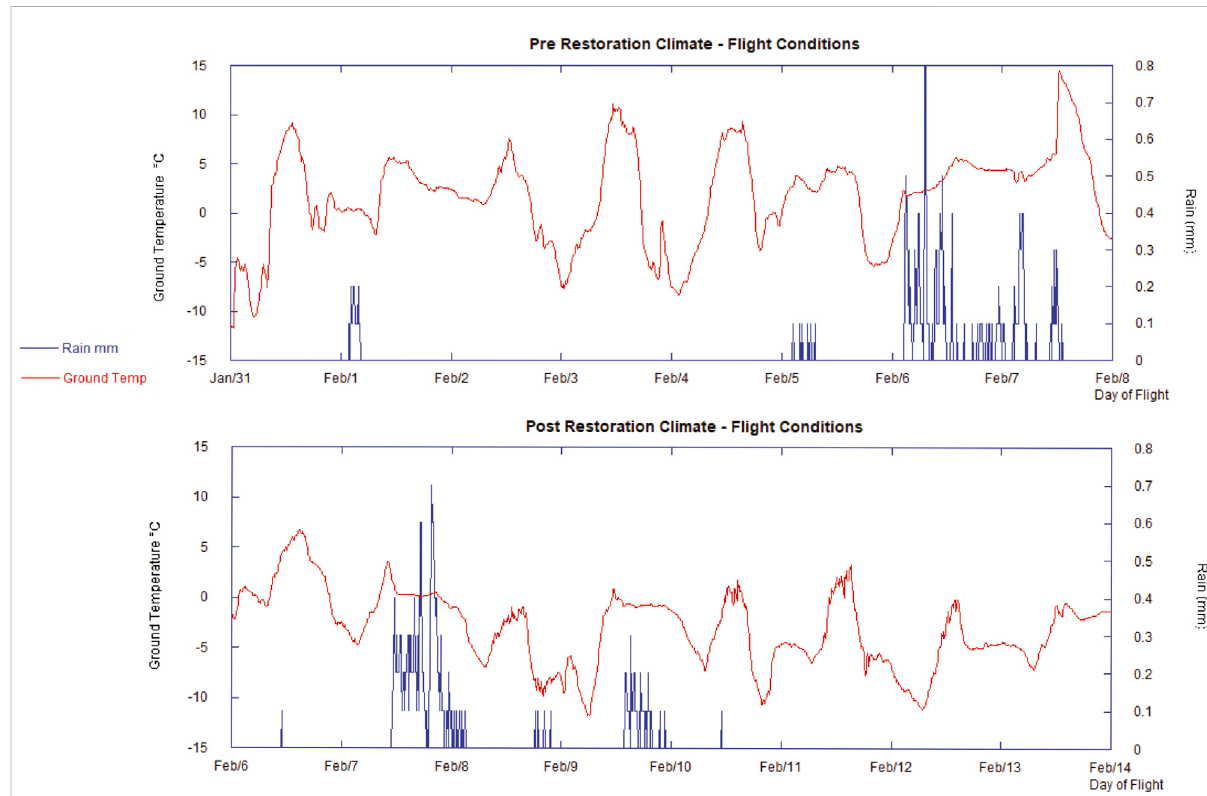
FIGURE 2 Plot of precipitation (mm, blue) and ground temperature ( ° C, red), leading up to the pre-restoration UAS fl ights at Foothills Preserve on 8 February